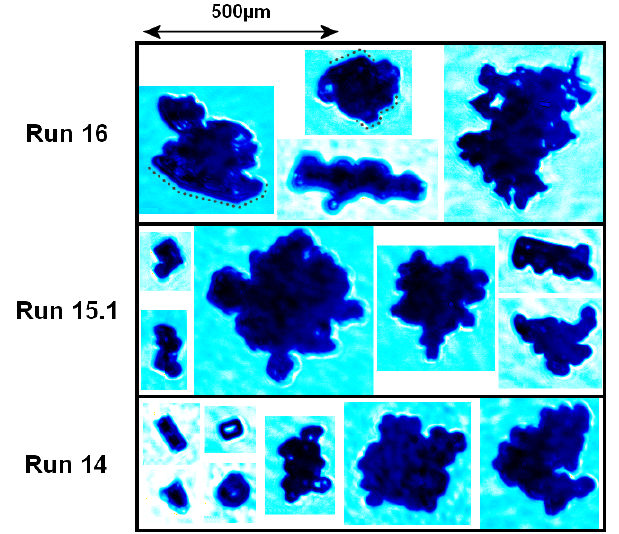
Figure 10. Images of hydrometeors measured by the CPI during selected runs from Fig. 7. Only a few images were recorded on each run, so they are not classified by vertical velocity. The dashed lines are to aid the reader’s eye to the plate-like features, which may be difficult to see